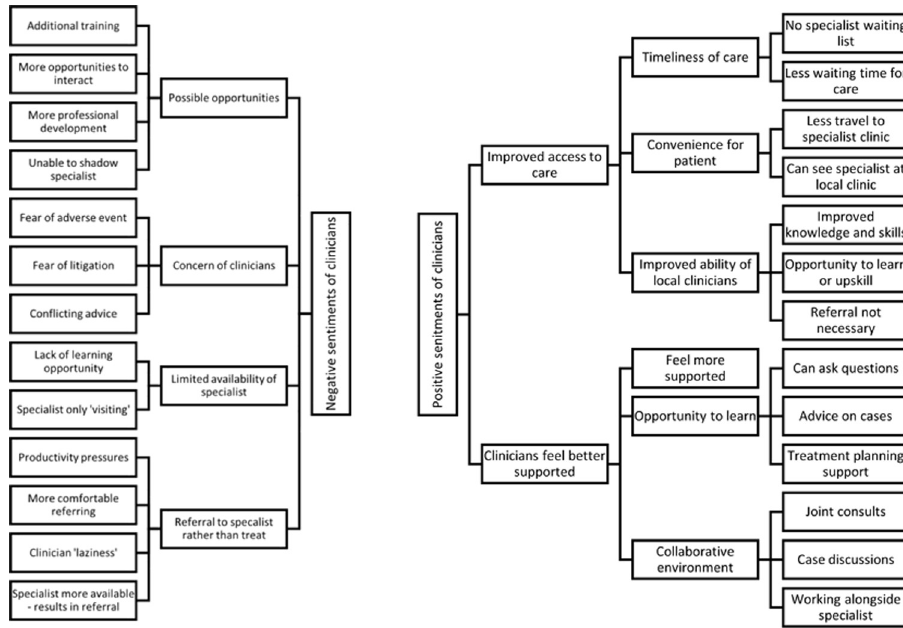
Fig 1. Coding tree for clinician